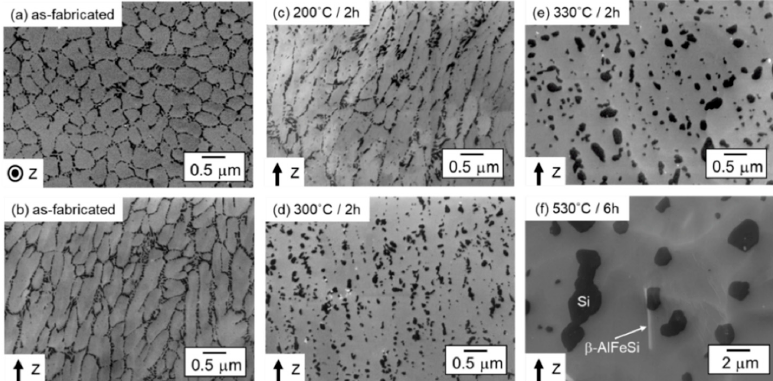
Figure 5. SEM micrographs showing microstructures of ( a , b ) as-fabricated, ( c ) 200 °C/2 h annealed, ( d ) 300 °C/2 h annealed, ( e ) 330 °C/2 h annealed and ( f ) 530 °C / 6 h annealed samples observed from the sections ( a ) normal and ( b – f ) parallel to the building direction (z axis).